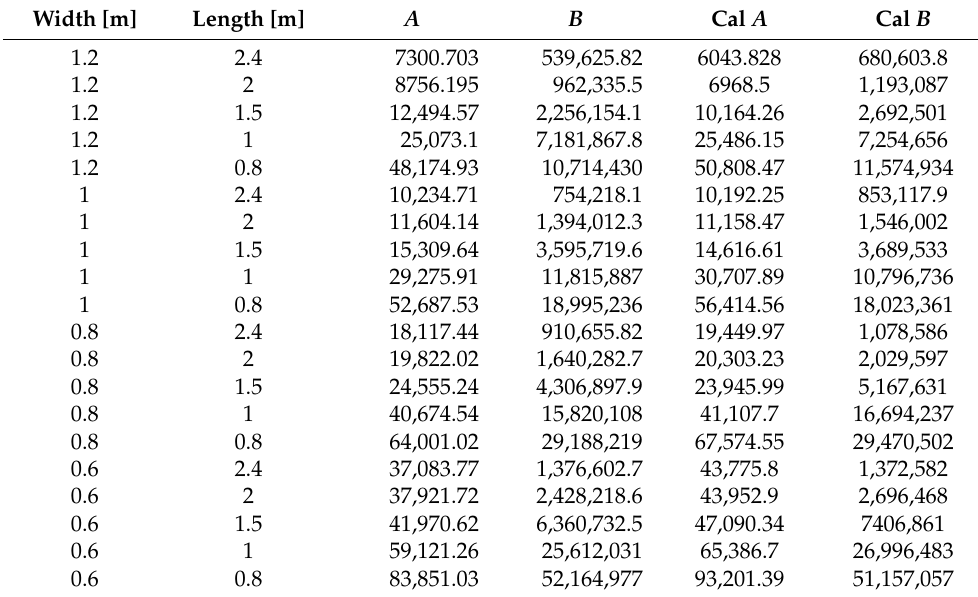
Table A12. The 16 mm plate FEA A , B and theory calculated A , B